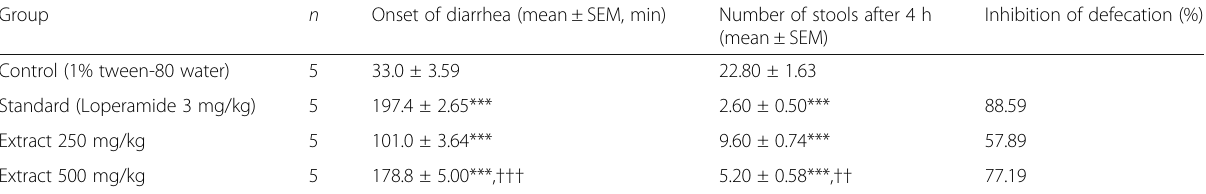
Table 5 Effects of Lepisanthes rubiginosa L. on castor oil-induced diarrhea in mice Group n Onset of diarrhea (mean ± SEM, min) Number of stools after 4 h